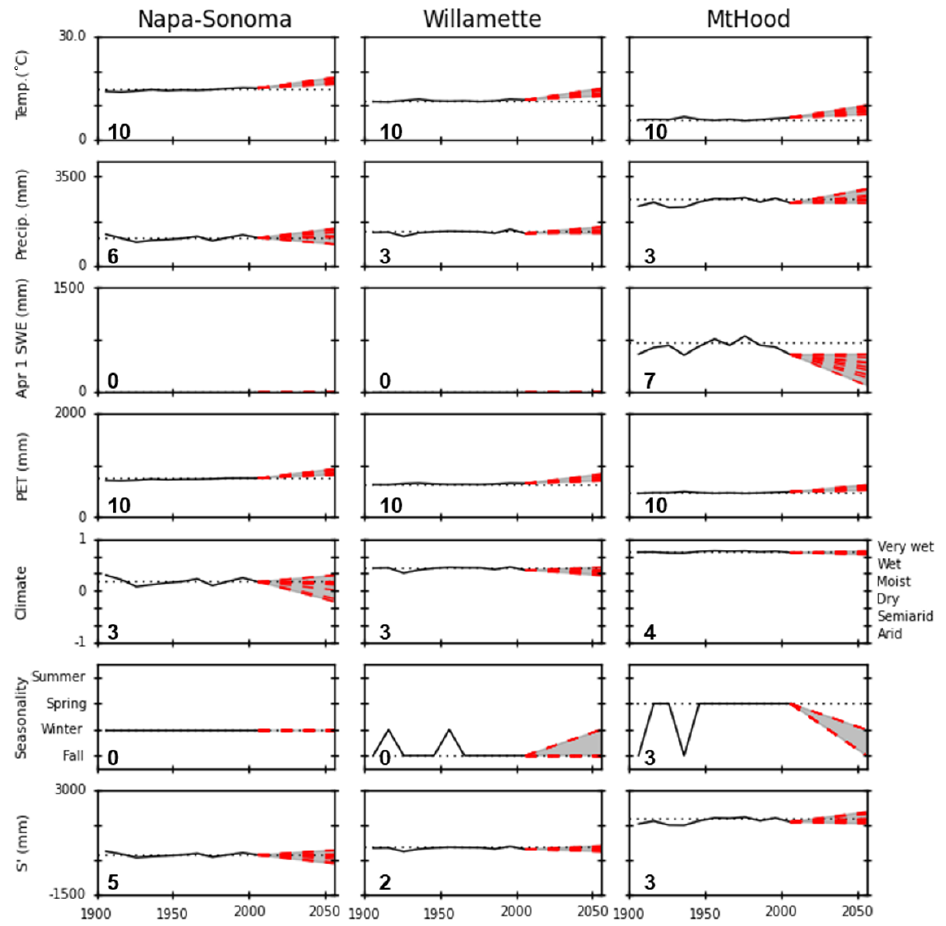
Figure 5. Time series of average decadal temperature, precipitation, snow (1 April snow water equivalent – mm), potential evapotranspiration (PET), climate (FMI), seasonality, and available water ( S (cid:48) ) for three specific locations in the western U.S. For the climate/FMI figures, the FMI values range from 1 to − 1 (primary y axis on the left), whereas the categorical version of the index ranges from arid to very wet (secondary y axis on the right). Dotted black line represents the 1971–2000 base period; the dashed red line connects the 2001–2010 value to the 2041–2070 climate projections for each of the 10 models. The gray shaded area represents the range of model projections. The number in the lower left indicates the vulnerability index for the metric and location depicted in the associated